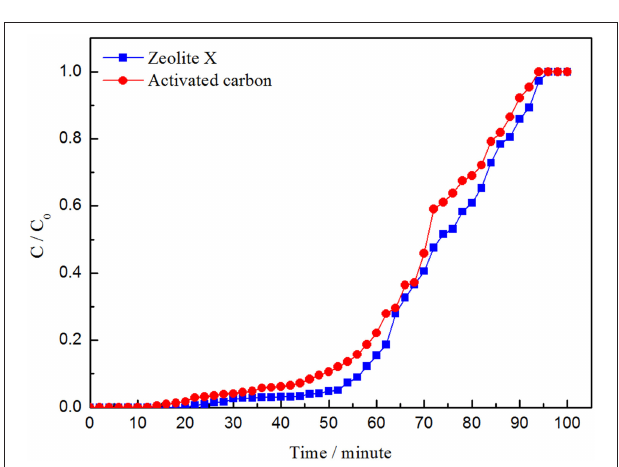
FIGURE 9 | Adsorption curves of benzene by zeolite X and activated carbon.